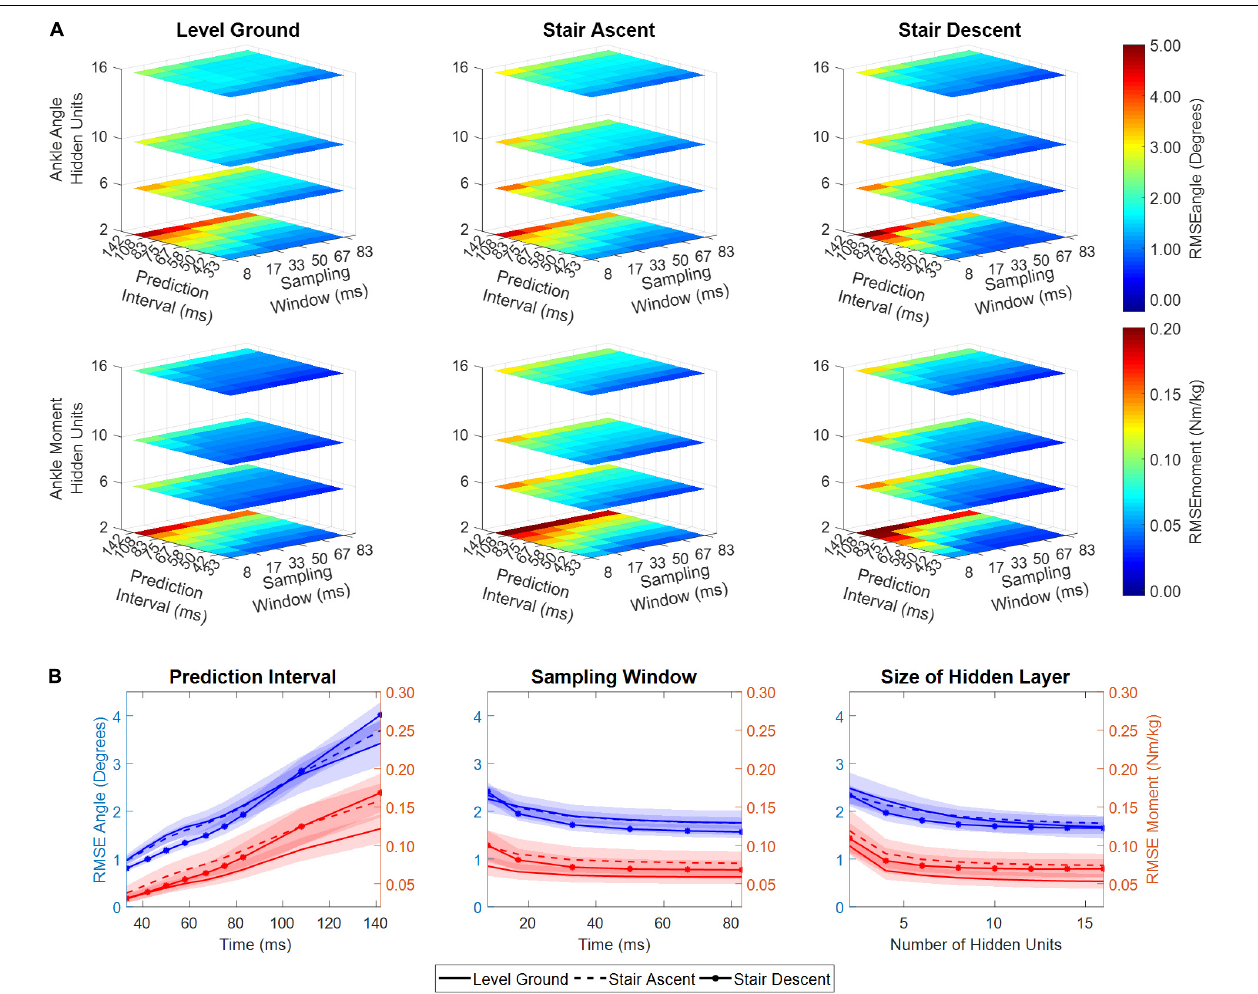
FIGURE 4 | (A) RSME between predicted and experimentally measured ankle angle and ankle moment as a function of NARX model prediction interval, sampling window, and number of hidden units, averaged across participants. (B) RMSE ankle angle and moment collapsed across model parameters (i.e., averaged across two of the three dimensions). Shaded regions denote ± 1 standard deviation. RMSE is shown for the first set of NARX models trained with error goal bounded to 1-percent of the moment variance of all recorded trials.